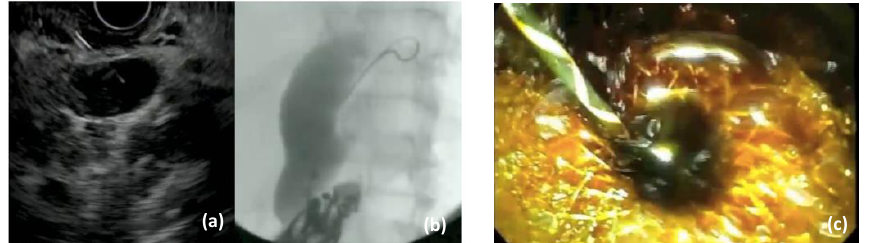
Figure 4. EUS-directed choledochoduodenostomy with ( a ) initial puncture of CBD from the duodenum; ( b ) contrast injection and insertion of a guidewire; ( c ) endoscopic aspect after deployment of a lumen apposing self-expandable metal stent.